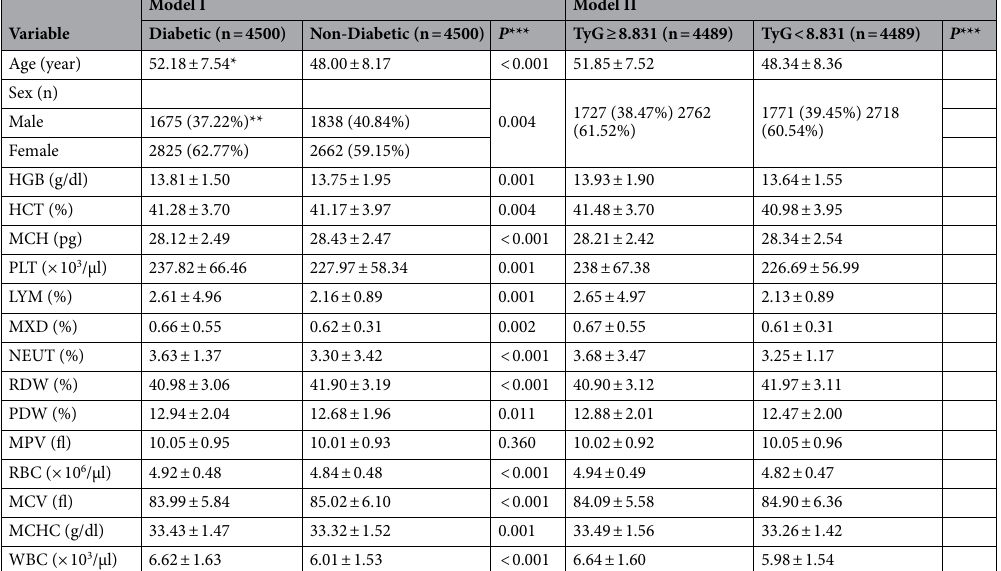
Table 1. Clinical characteristics at the baseline of Mashhad stroke and heart atherosclerotic disorder (MASHAD) study used in this paper. *Mean ± Sd. **n(%). *** P- value based on 2 sample t-test for Mean ± Sd and Chi-sq test for frequency (%). HGB Hemoglobin, HCT Hematocrit, MCH Mean corpuscular hemoglobin, PLT Platelet count, LYM Lymphocyte count, MXD Mixed cell count, NEUT Neutrophil count, RDW Red cell distribution width, PDW Platelet Distribution Width, MPV Mean platelet volume, RBC Red blood cell, MCV Mean corpuscular volume, MCHC Mean corpuscular hemoglobin concentration, WBC White blood cell, TyG